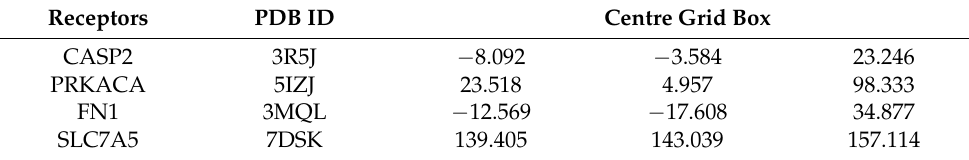
Table 3. Parameters of the grid box.